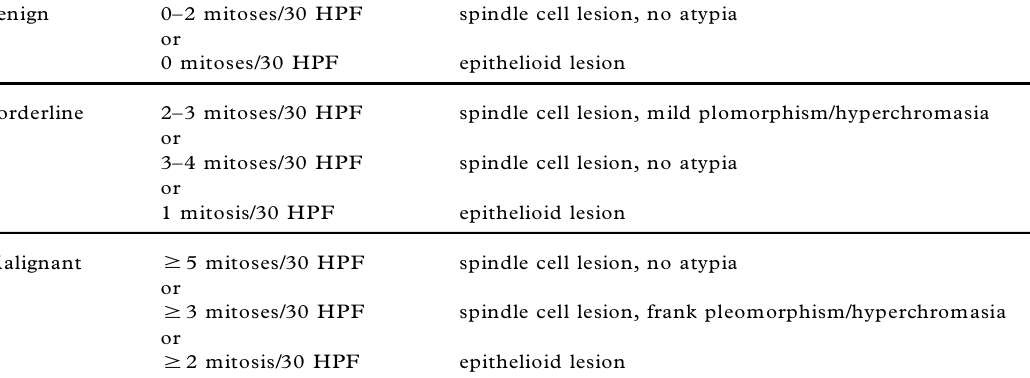
Table 1 . Histological criteria for grading gastrointestinal stromal tumours Benign 0± 2 mitoses/30 HPF spindle cell lesion, no atypia epithelioid